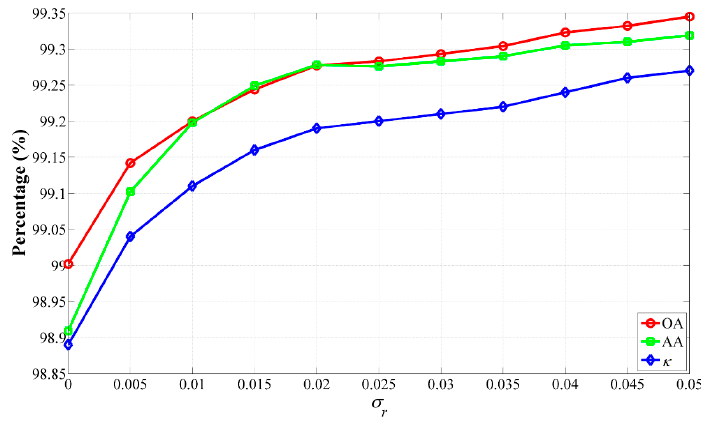
Figure 14. Analysis of the impact of the parameter σ r on classification accuracies using the CS-GC + JBF method for the Salinas data set. Table 6. The impact of different parameter settings on classification accuracies using the CS-GC + JBF method for the University of Pavia data set. The highest accuracies are indicated in underlined in each